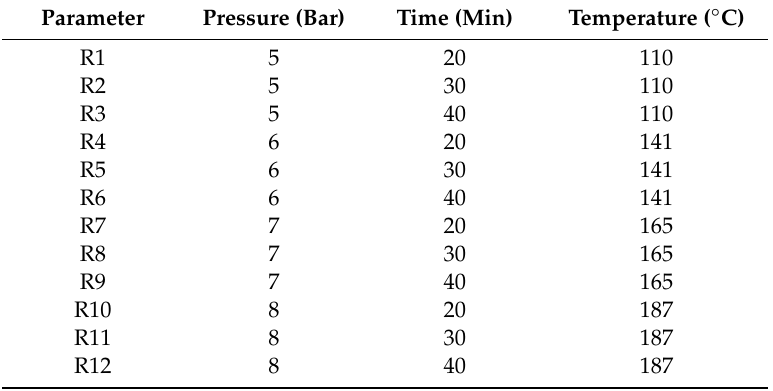
Table 3. Operating conditions in the BMP test for optimal thermal hydrolysis.